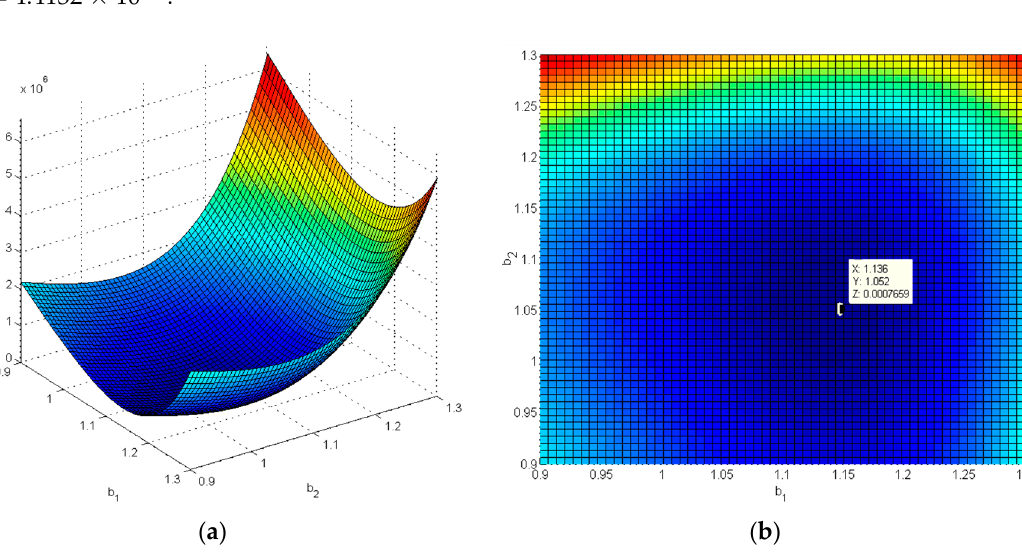
Figure 11. Simulation result of MATLAB: ( a ) 2-D parameter surface of β 1 and β 2 ; ( b ) Minimum point of β 1 and β 2 .